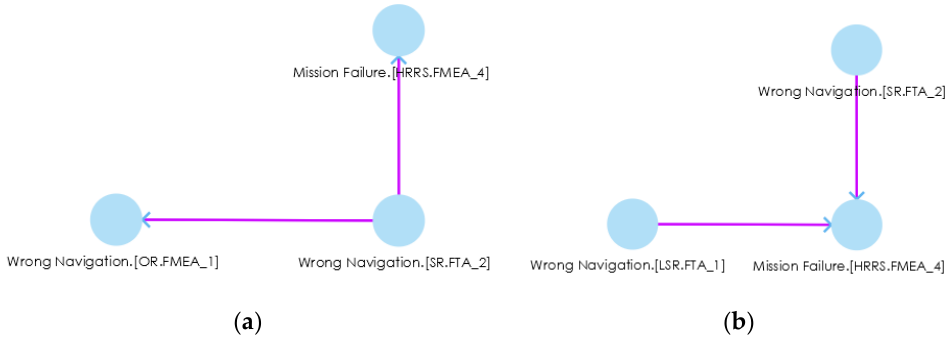
Figure 7. ( a ) Fault propagation route for Wrong Navigation.(SR.FTA_2) , ( b ) back traceability of a particular fault ( Mission Failure.(HRRS,FMEA_4 ) in impact analysis .